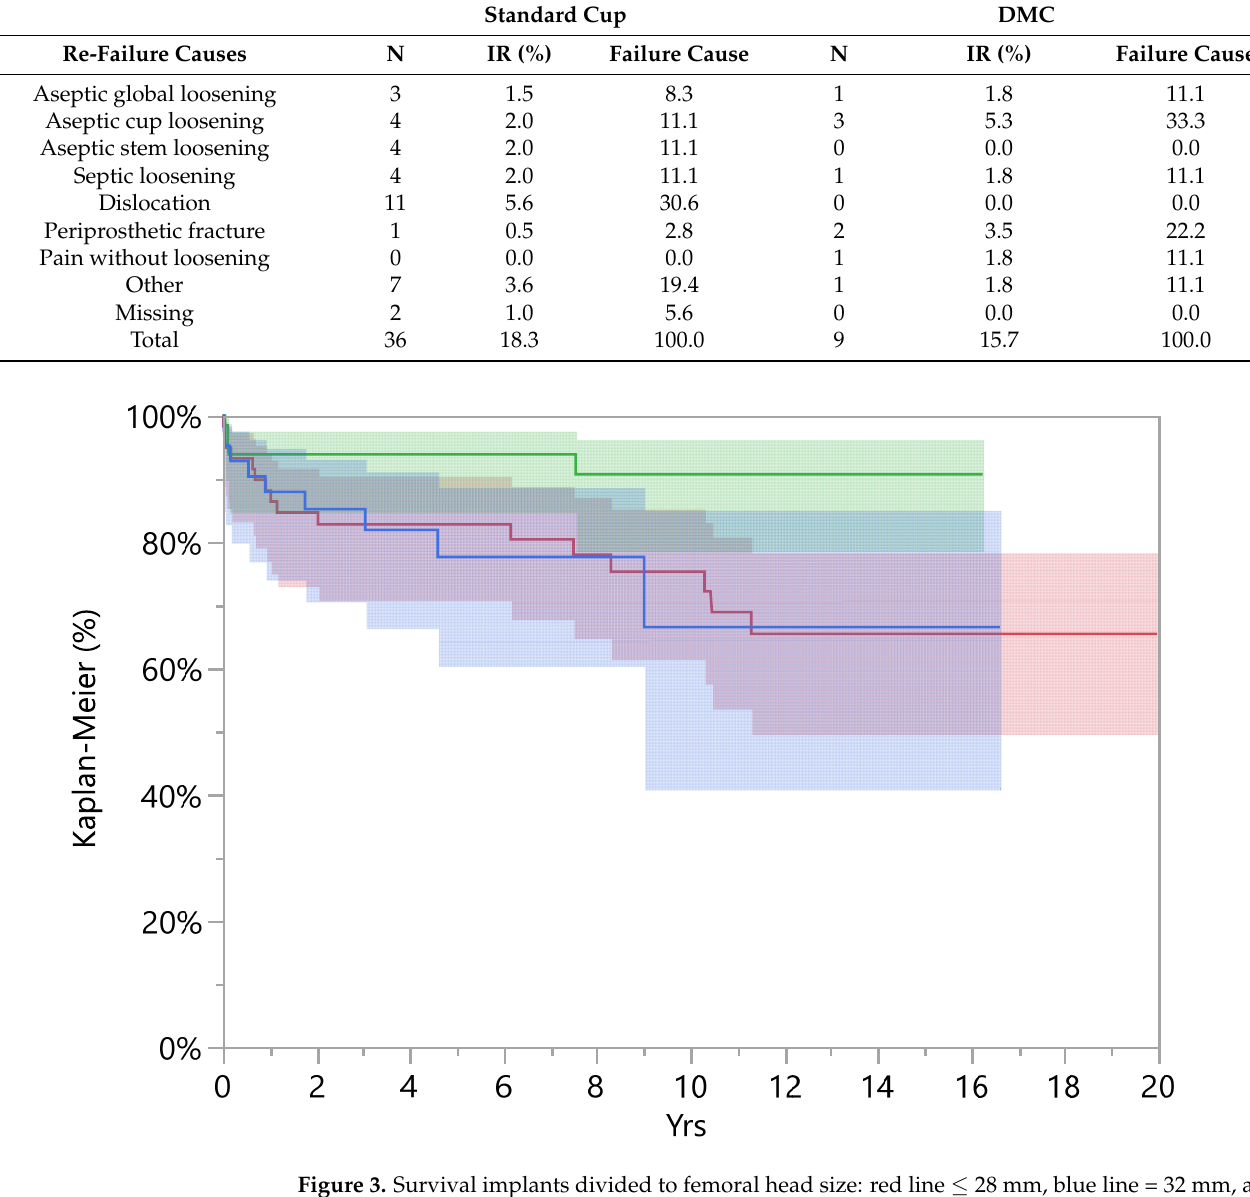
Figure 3. Survival implants divided to femoral head size: red line ≤ 28 mm, blue line = 32 mm, and green line ≥ 36 mm.